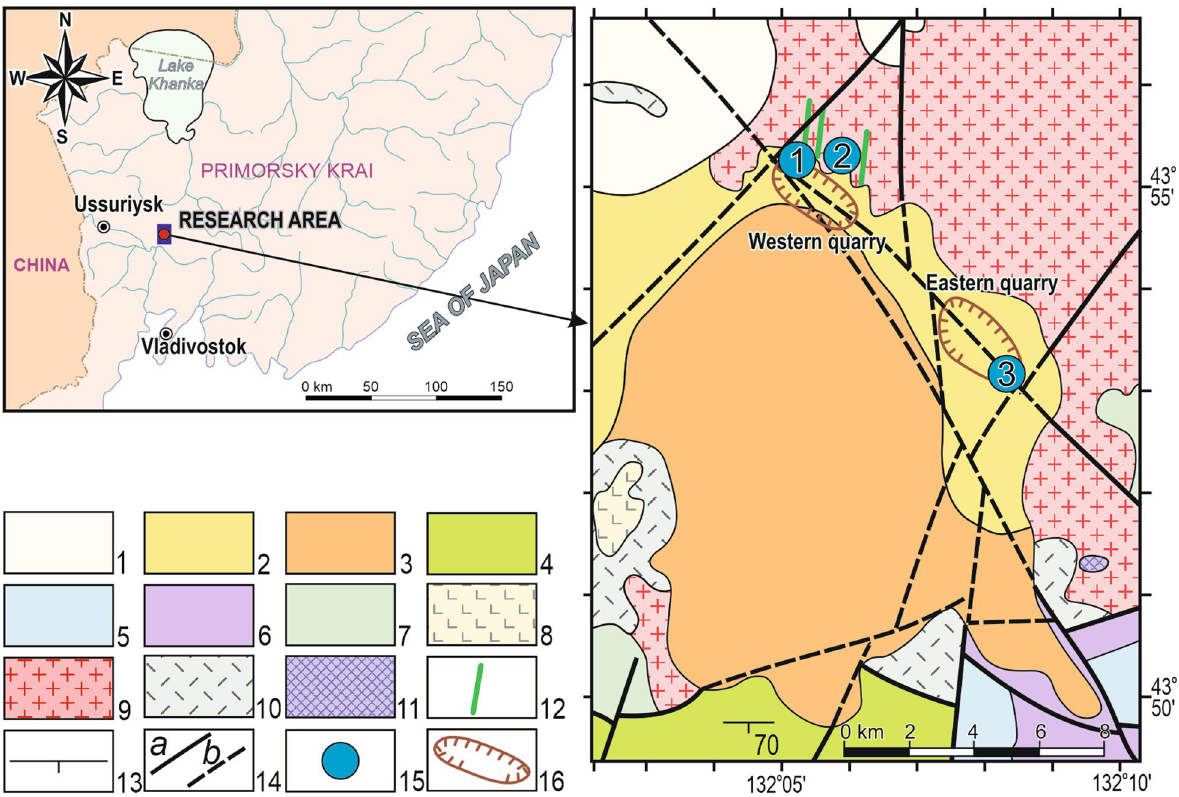
Fig. 1 The location and geological scheme of the Rakovka depres- sion. 1—Quaternary deposits; 2—Late Miocene: poorly consolidated sandstones, pebbles, tuffites, diatomites; 3—Oligocene: sandstones, siltstones, tuffites, conglomerates, brown coals; 4—Early Creta- ceous: sandstones, siltstones, conglomerates, gravelites, clayey lime- stones; 5—Middle Jurassic: sandstones, siltstones, tuffites; 6—Late Triassic: sandstones, siltstones, carbonaceous shales, hard coal